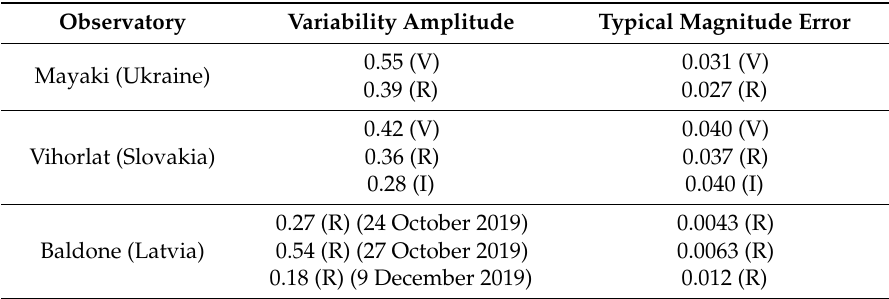
Table 3. Table of variability amplitudes and errors (in fractions of magnitude) of observations of the 3C 371 source at the observatories in Ukraine, Slovakia and Latvia at